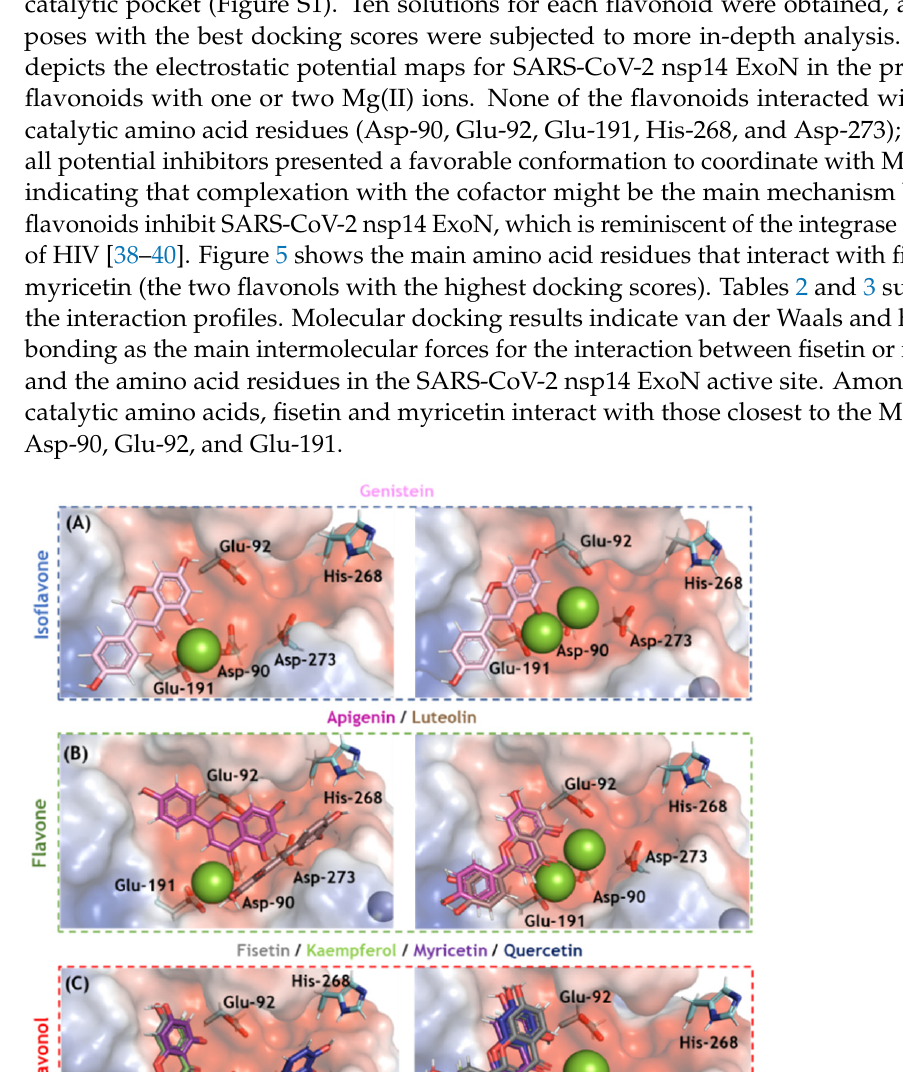
the best docking poses for the flavonoids ( A ) isoflavone, ( B ) flavones, and ( C ) flavonols in the SARS-